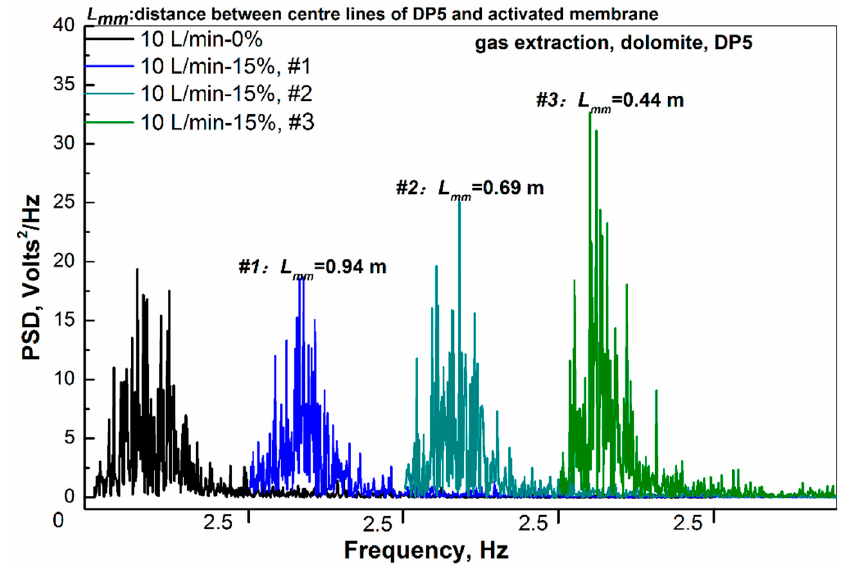
Figure 6. Effects of the extraction location on the power spectra of the differential pressure measured at DP5. The other operational conditions were: T = 550 °C, P = 0.1 MPa, H ini = 1.28 m, U = 0.09 m/s, extraction rate = 1.5 L/min, calcined dolomite.